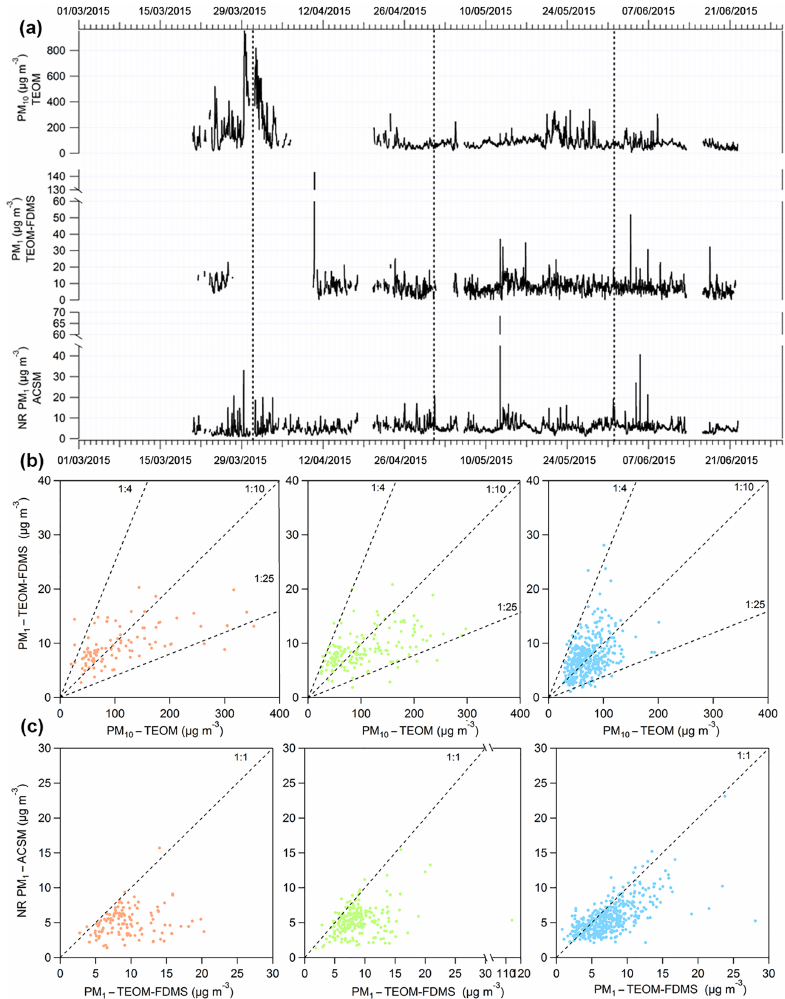
Figure 3. (a) NR PM 1 , total PM 1 and PM 10 time series (30min averages) measured over IOP-1, (b) 2h averaged scatter plots of total PM 1 vs. PM 10 and (c) NR PM 1 vs. PM 1 for (left) continental, (middle) sea breeze and (right) marine days (dotted lines are visual markers representing ratios between the different